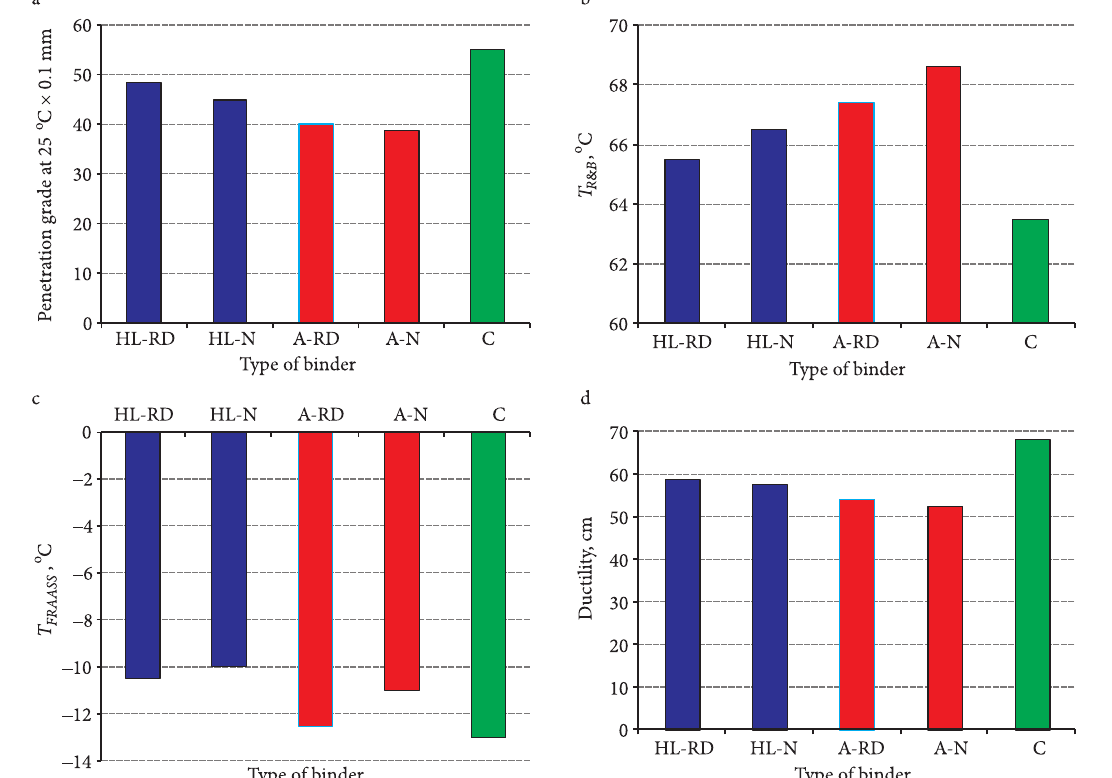
Fig. 1. Properties of the bitumen extracted from SMA after 12 years in operation: a – penetration grade at 25 °C; b – softening point temperature; c – breaking point temperature; d – bitumen